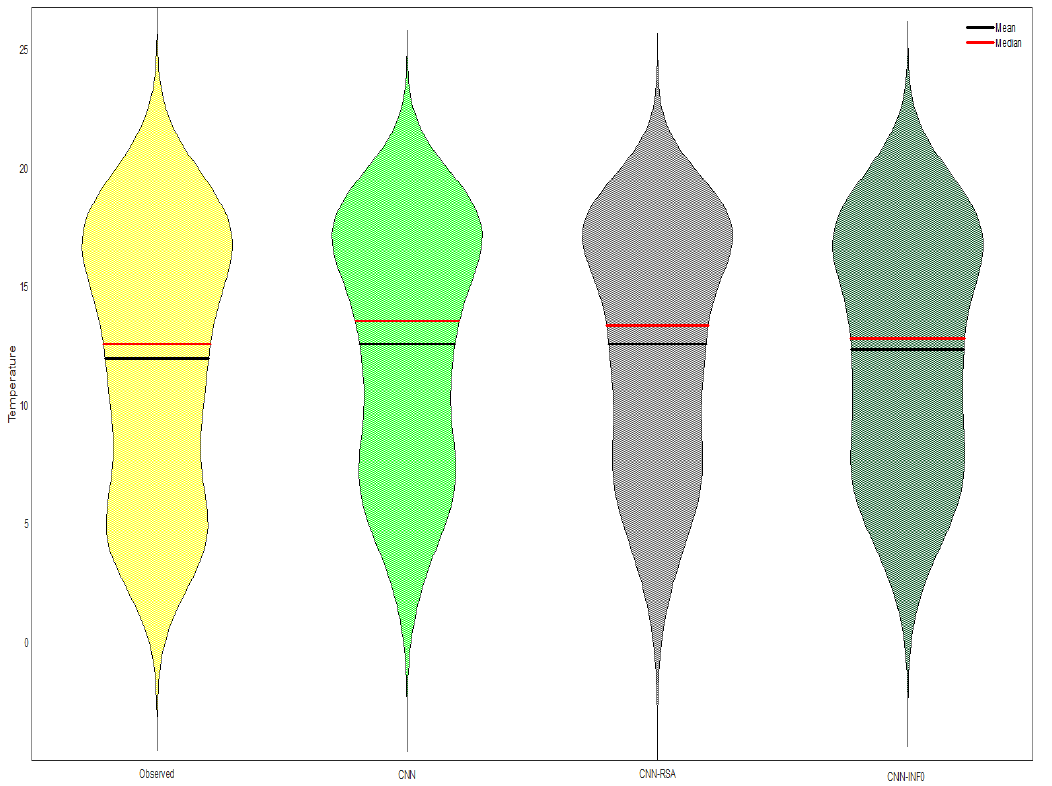
Figure 10. Violin charts of the predicted water temperature using different CNN-based models in the test period with the best input combination.